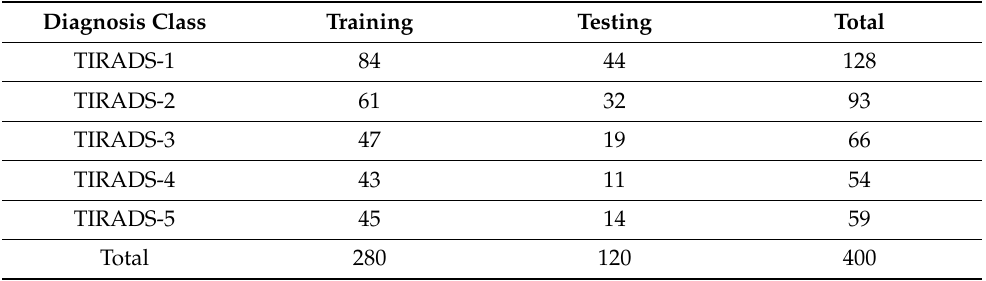
level. Table 2 lists the details of the proposed and benchmark models’ training parameters, such as learning rate, drop rate, weight decay, and optimizer. Table 1. Distribution of dataset for Testing and Training.